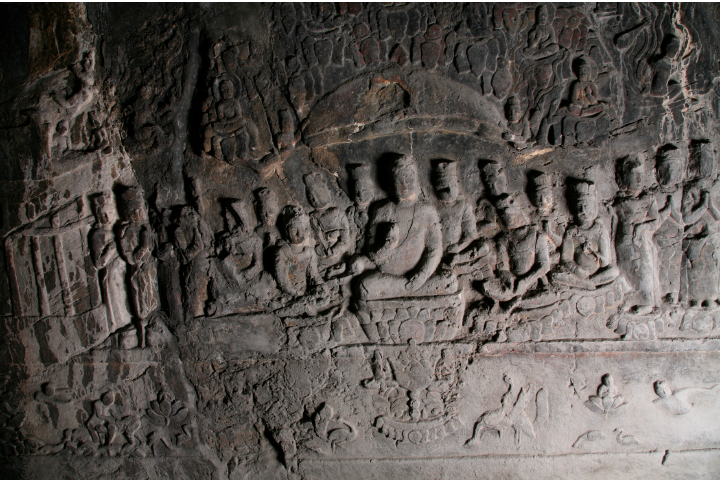
Figure 5. West Pure Land of Amitabha, Xiangtangshan Cave 1, sixth-century Northern Qi (Freer Gallery of Art).